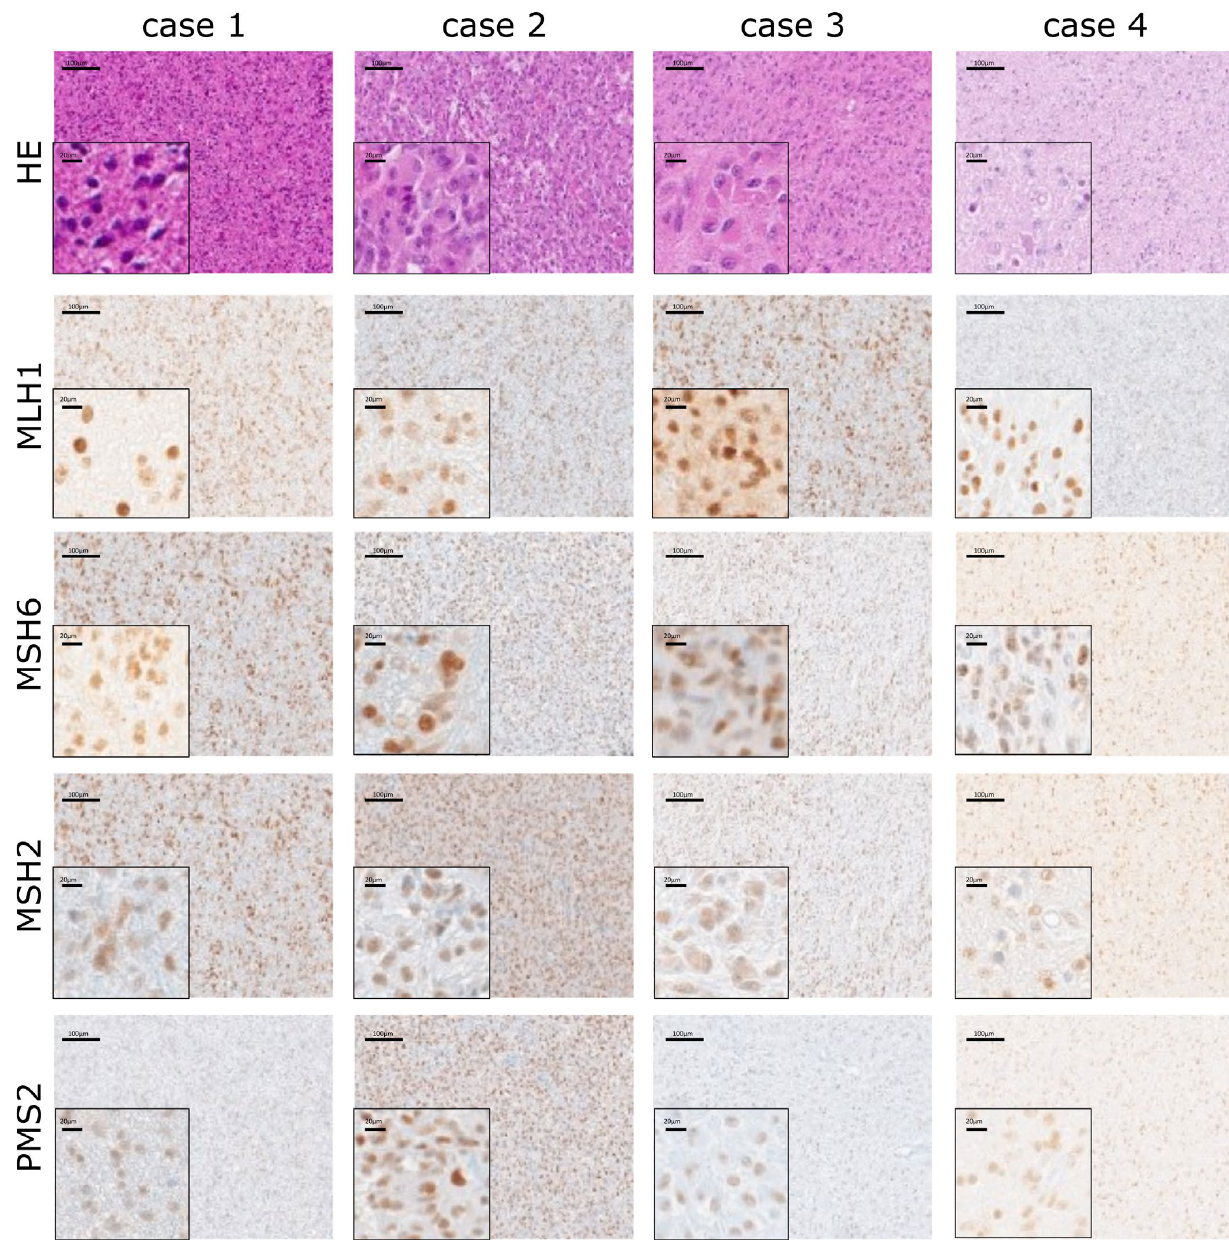
Figure 3. Representative images of the hematoxylin/eosin (HE) staining and the immunohistochemical staining for the mismatch repair system (MMR). All four cases show a positive MMR signal. Case 1 represents MGMT met+ /MMGT high , case 2 MGMT met− /MGMT high , case 3 MGMT met+ /MGMT low and case 4 MGMT met− /MGMT low . Brownish color indicates a positive MMR staining with diamino- benzidine. Images were taken using a 3D Histech Scanner , and exemplary areas were determined via the Panoramic Viewer software. Scale bar = 100 µm.